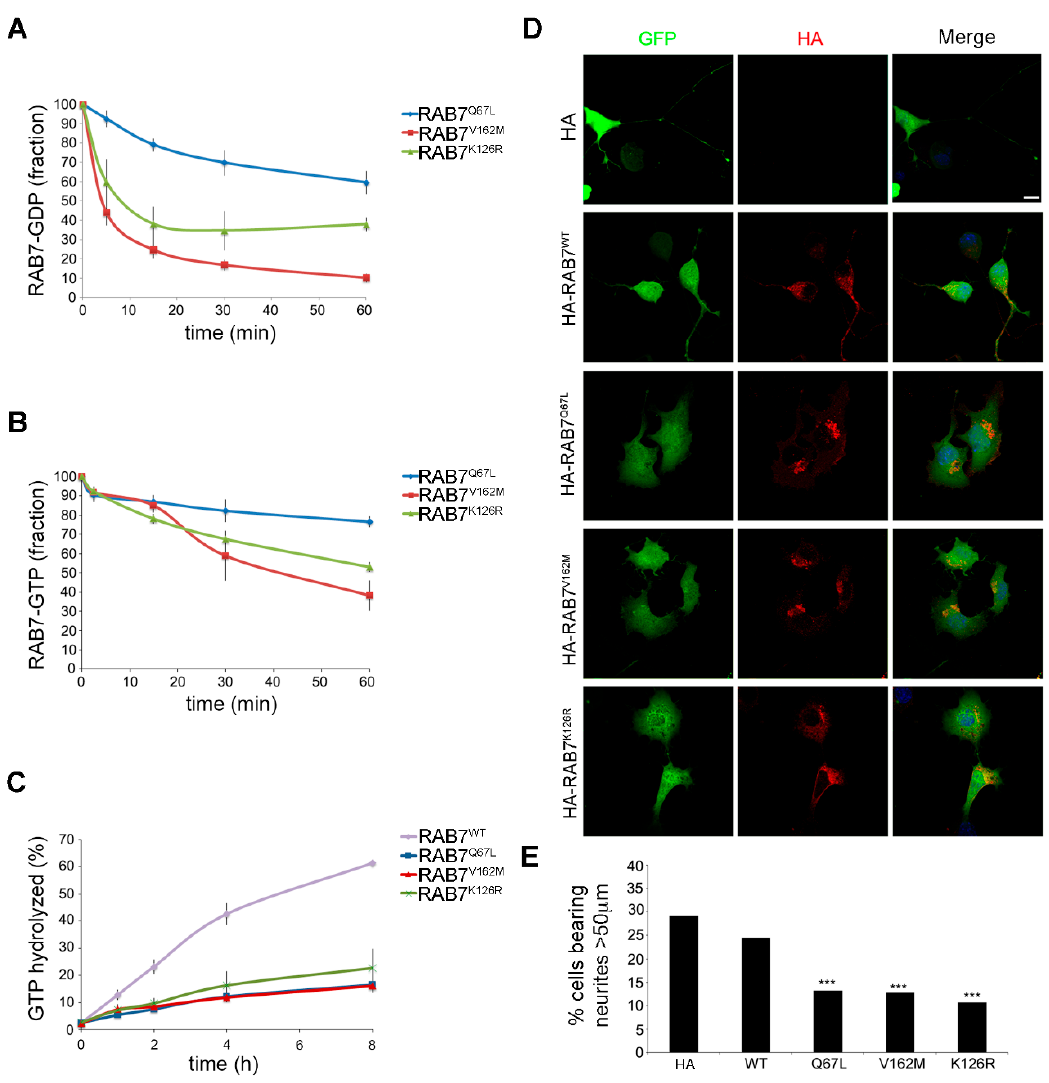
Figure 2. Biochemical and biological properties of the RAB7 K126R mutant protein. ( A , B ) Dissociation of guanine nucleotides from RAB7 K126R , RAB7 Q67L , and RAB7 V162M . Purified proteins were incubated with [ 3 H]GDP ( A ) or [ 3 H]GTP ( B ), then a 100× excess of cold competitor (GDP or GTP) was added and dissociation of nucleotide was monitored for 1h to calculate K off . ( C ) The measure of GTPase activity of RAB7 wt , RAB7 K126R , RAB7 Q67L , and RAB7 V162M purified proteins per binding event. Proteins were loaded with [ 32 P]GTP and then GTP hydrolysis was monitored during 8 h adding 100× fold excess of unlabeled GTP. ( D , E ) To analyze the effect of RAB7 K126R on neurite outgrowth, Neuro2A cells were co-transfected with the indicated HA-tagged RAB7 wt and mutant expressing constructs and with the pEGFPC1 plasmid to visualize entire cell and incubated for 24 h in serum-free medium to induce cell differentiation. ( D ) Confocal microscopy images of a field of cells per condition are shown. Scale bar = 10 μ m. ( E ) Quantification of neurite outgrowth in Neuro2A cells expressing different RAB7 wt and mutant proteins. Neurites were defined as processes longer than 50 μ m. The percentage of cells bearing neurites was calculated as the number of cells with neurites divided by the total number of cells. We compared the number of cells bearing neurites longer than 50 μ m between control cells (cells transfected with pEGFPC1 and HA empty plasmid) and cells expressing RAB7 wt and mutant proteins. We show a statistical analysis of three independent experiments ( χ 2 test, *** p < 0.001).